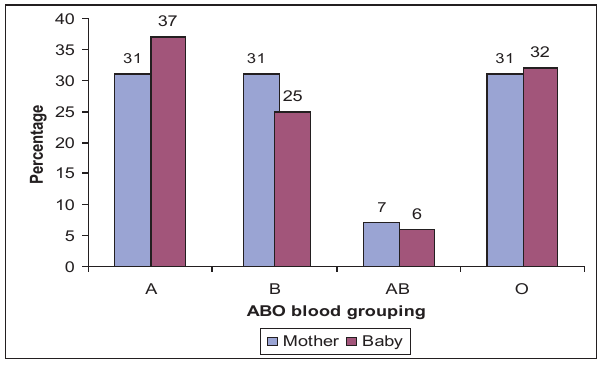
Fig 2. ABO blood groups of mothers and babies